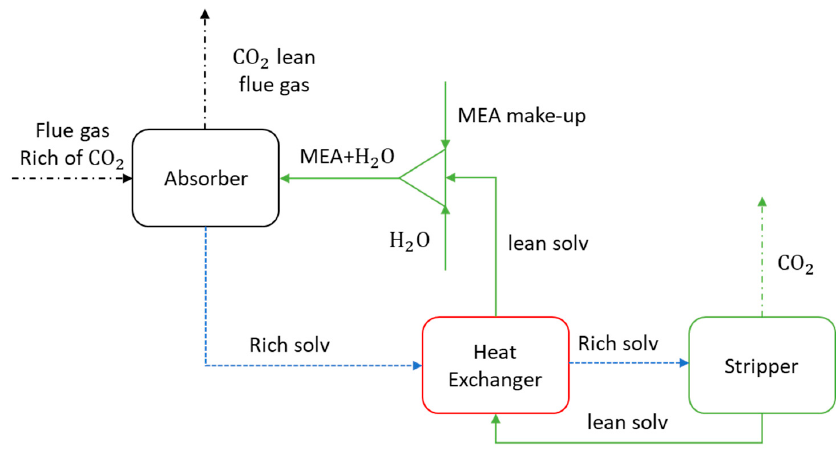
Figure 6. Scheme of post-combustion CO 2 capture with a chemical absorption process using aqueous monoethanolamine (MEA) solution.